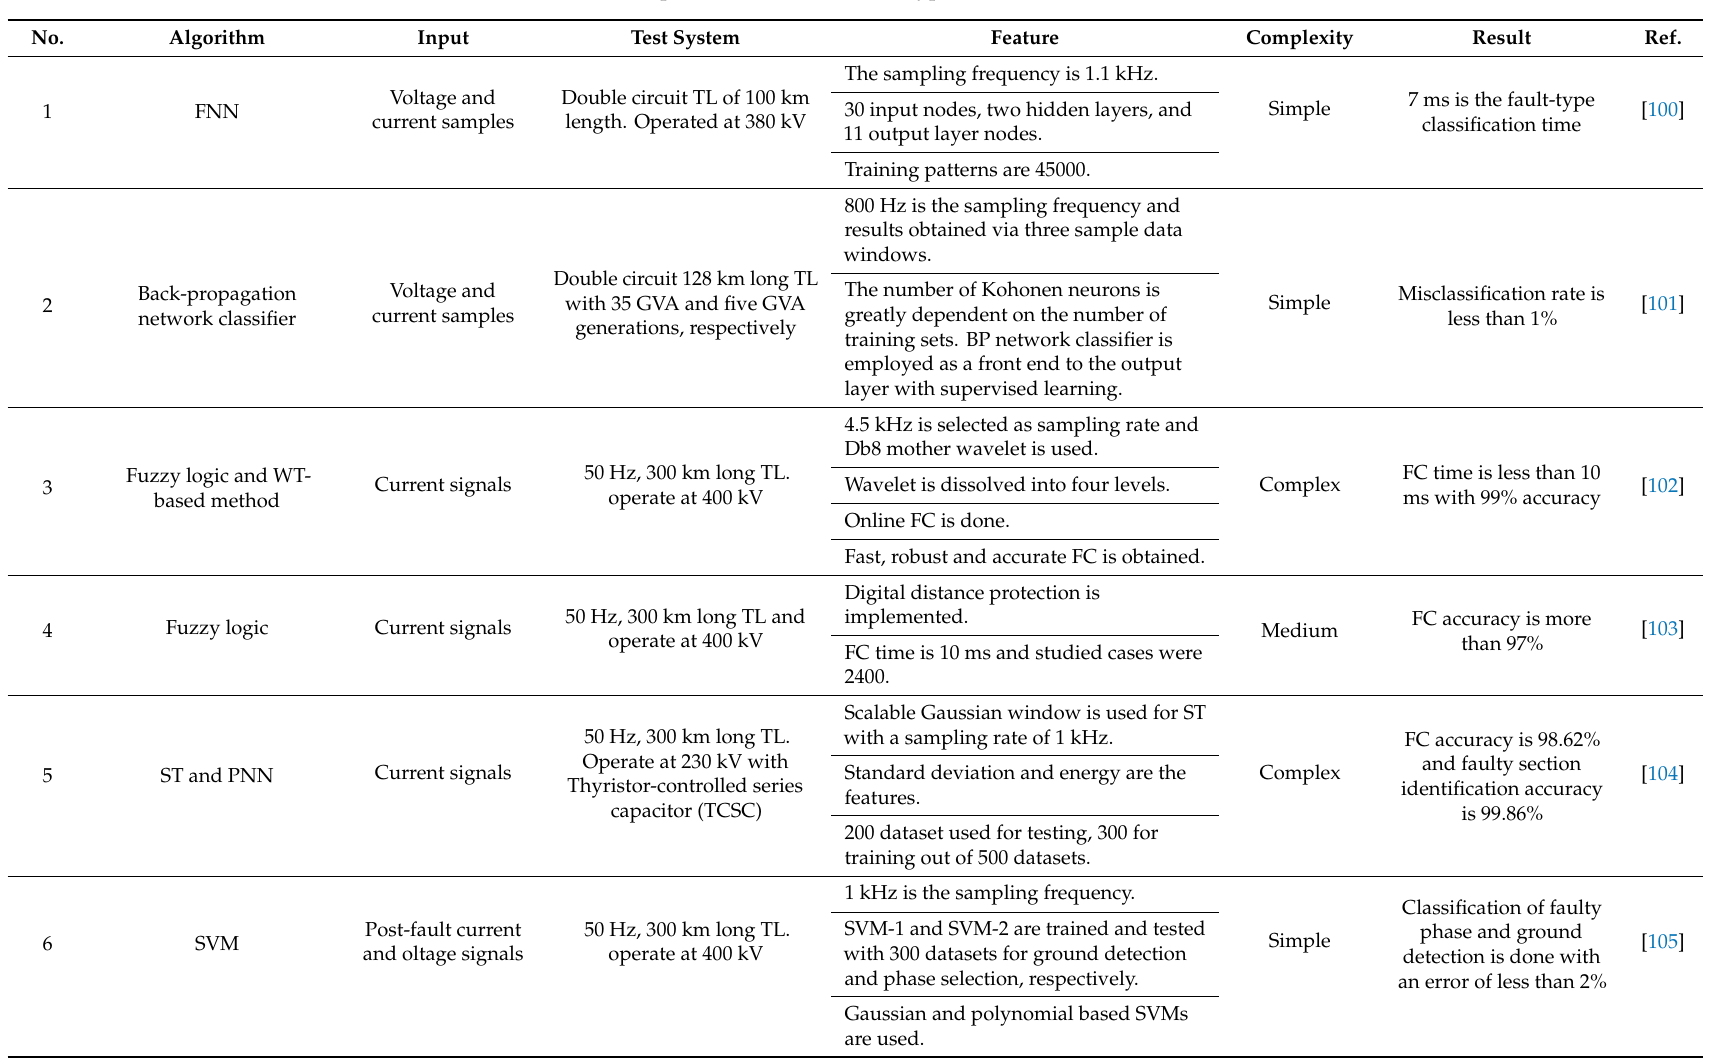
Table 2. Comparison of di ff erent fault-type classification